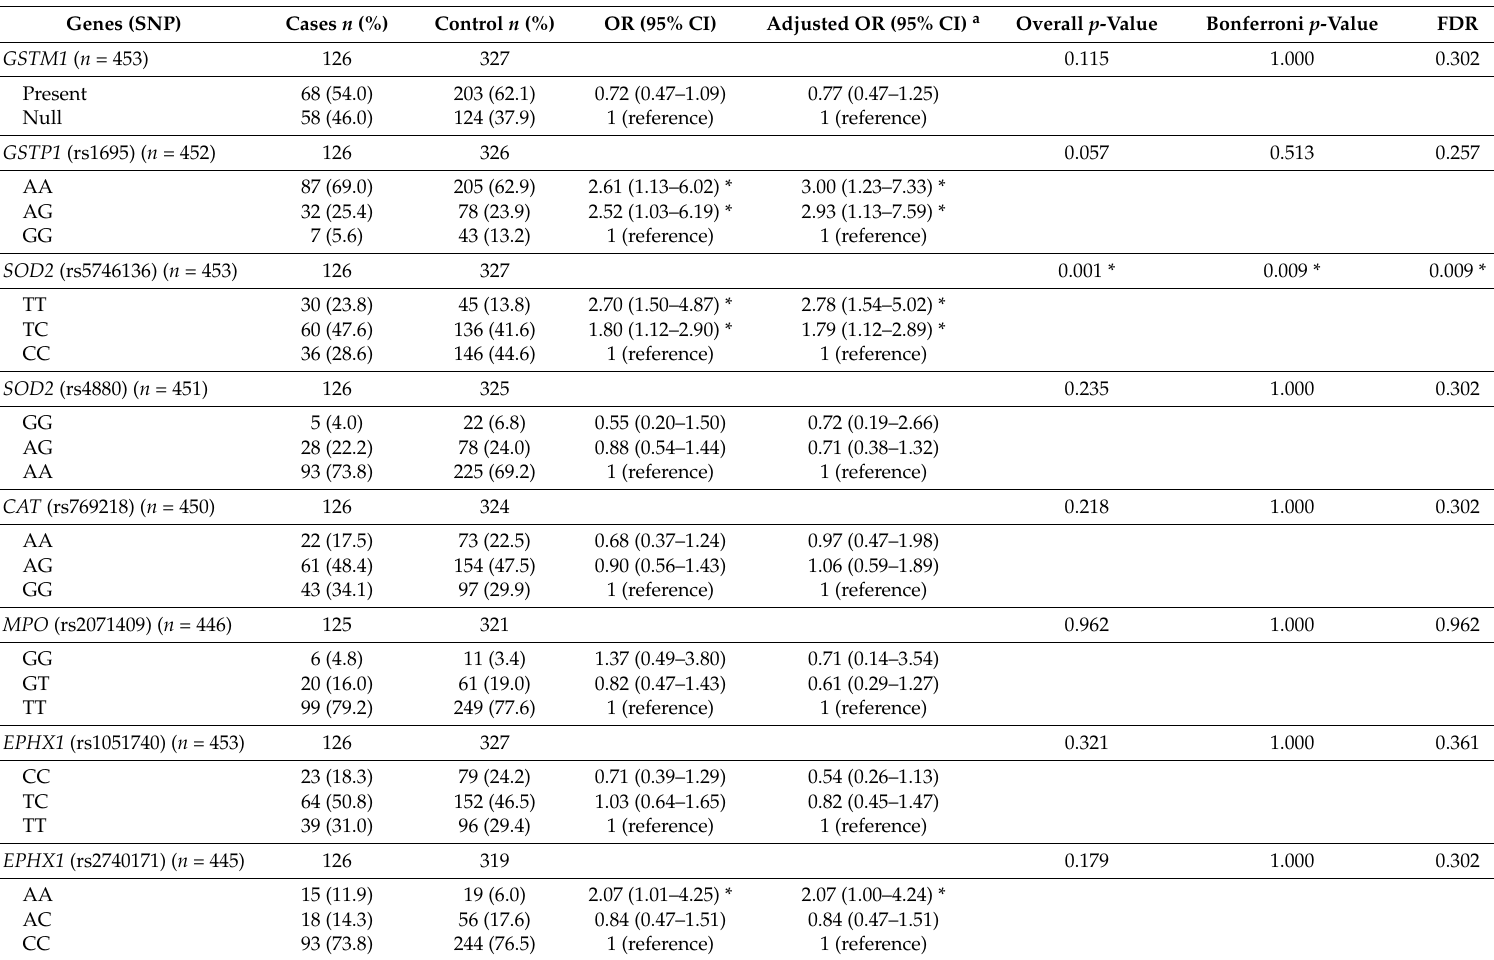
Table 3. The association of the genotypes of oxidative stress genes with